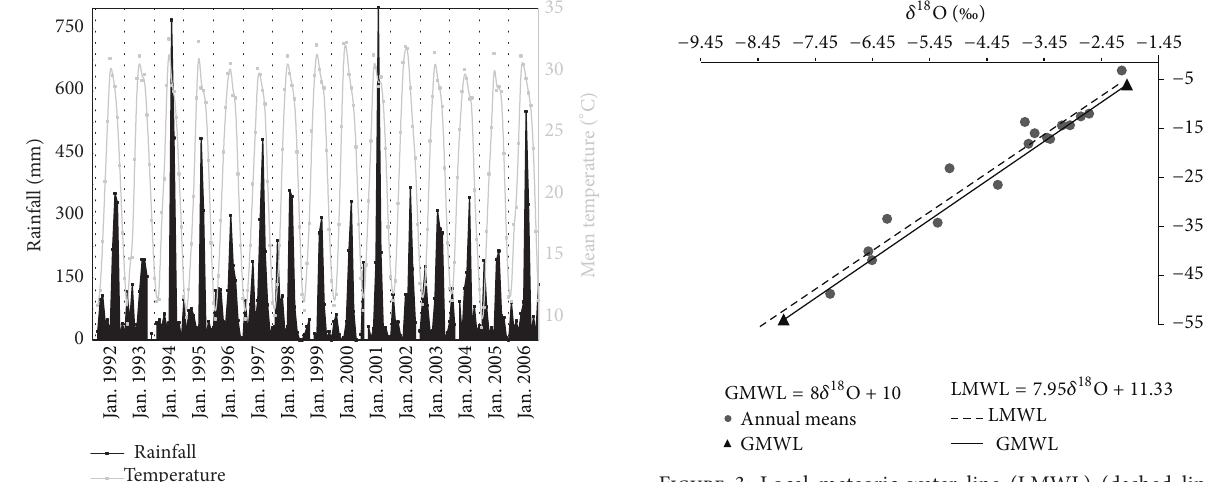
Figure 3: Local meteoric water line (LMWL) (dashed line) for Islamabad from the annual weighted mean data (1992–2006) and comparison to the global meteoric water line (GMWL) (solid line).